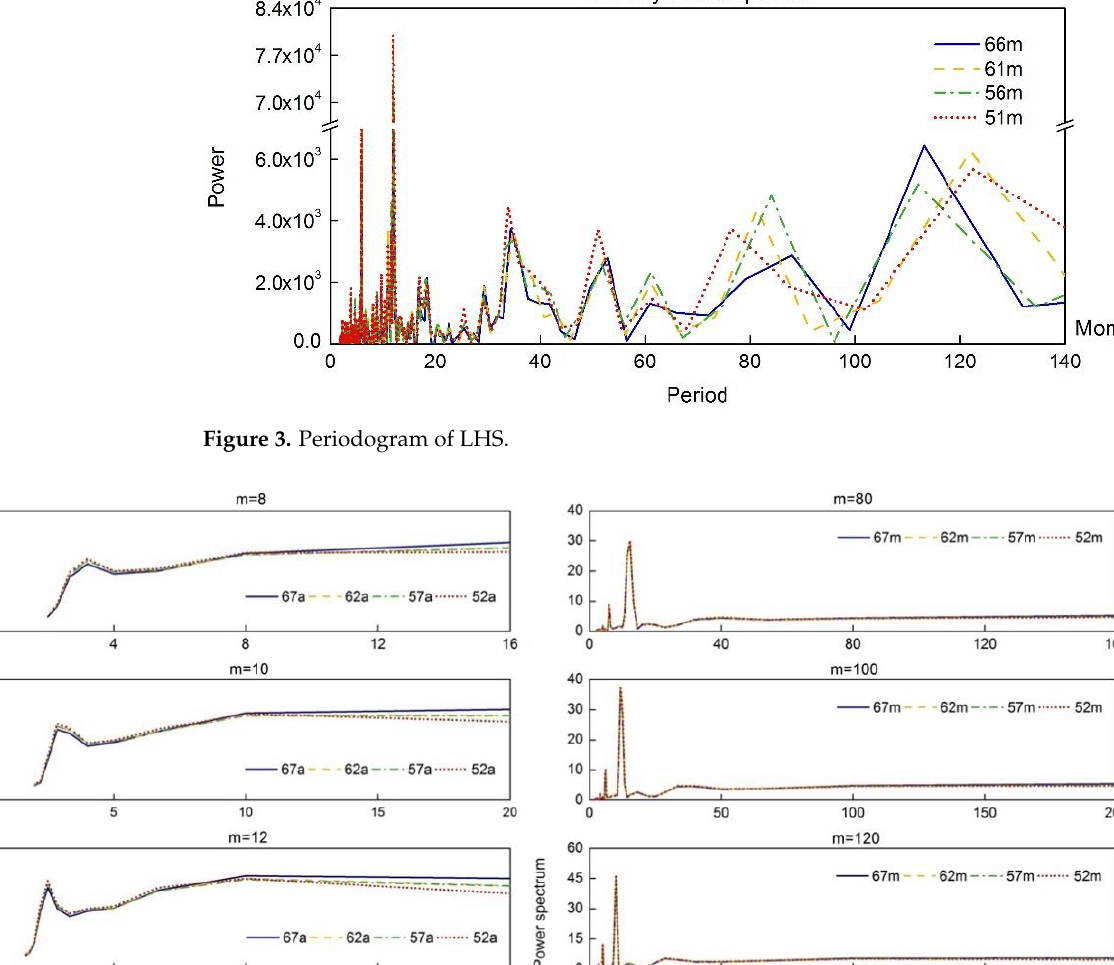
Figure 4. Power spectra of HHS.